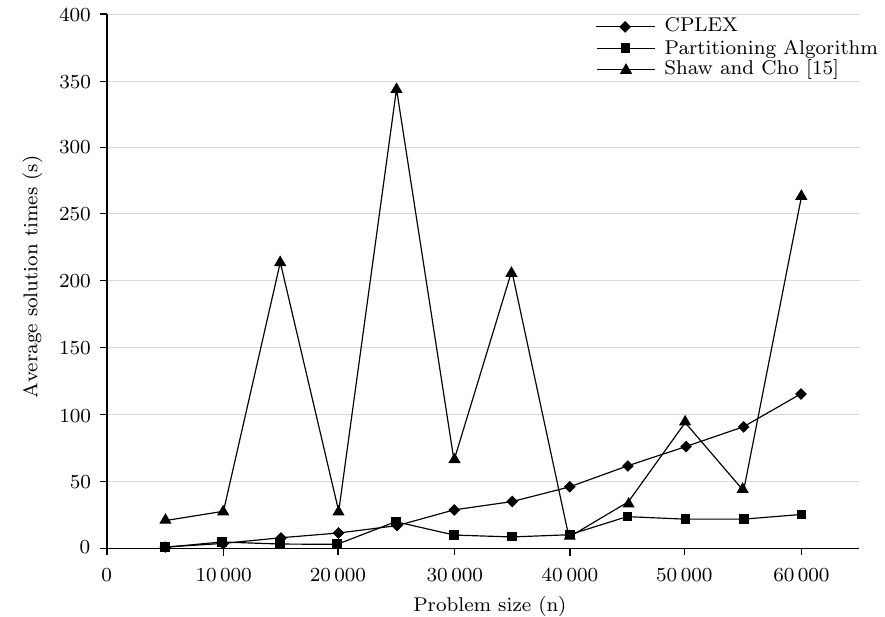
Figure 1: Average solution times for uncorrelated TKP data class.